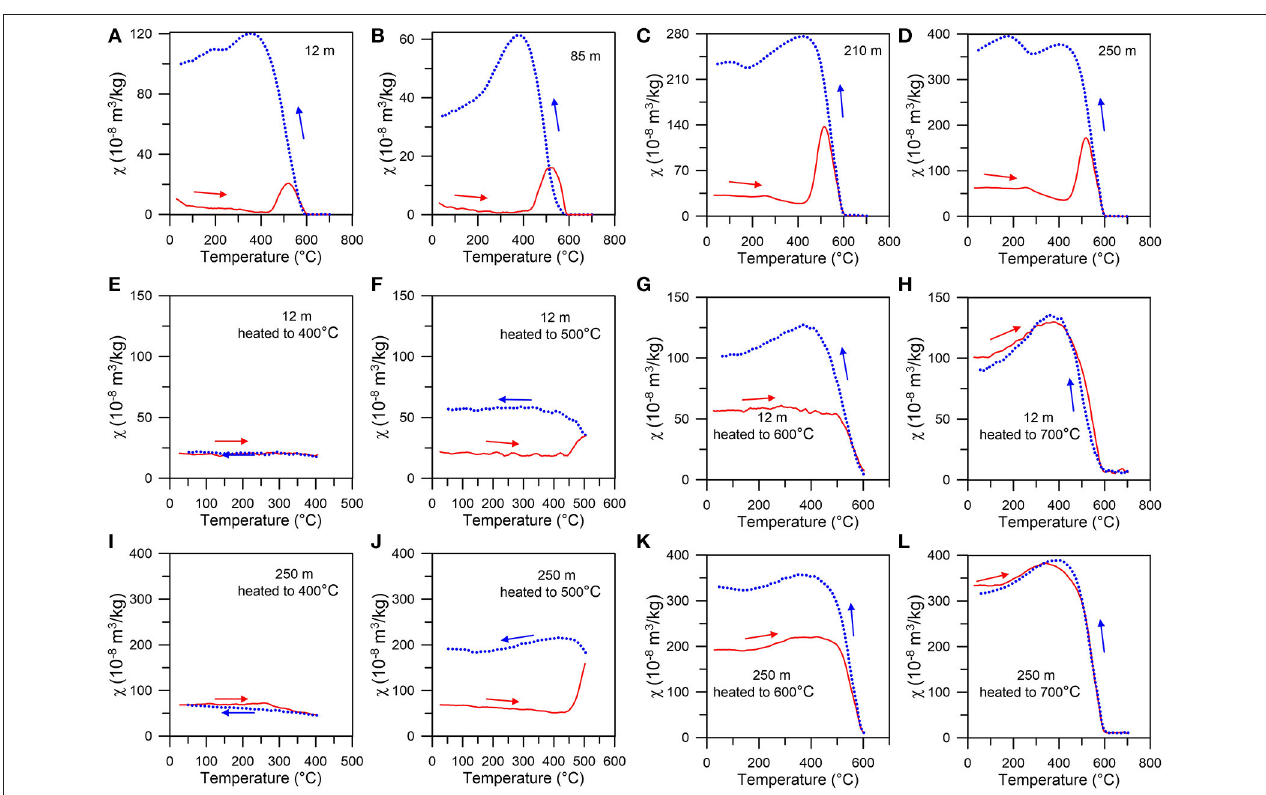
FIGURE 3 | Temperature dependence of magnetic susceptibility ( χ –T) of typical samples. (A–D) samples directly heated to 700 ◦ C, (E–H) the sample at 12m stepwise heated to 700 ◦ C, (I–L) the sample at 250m stepwise heated to 700 ◦ C. Red solid, blue dashed lines represent the heating (cooling)